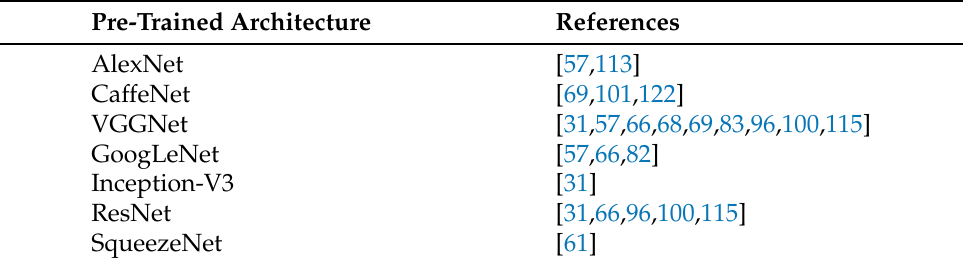
Table 11. The pre-trained architectures used for fine tuning with ELM reported in the primary